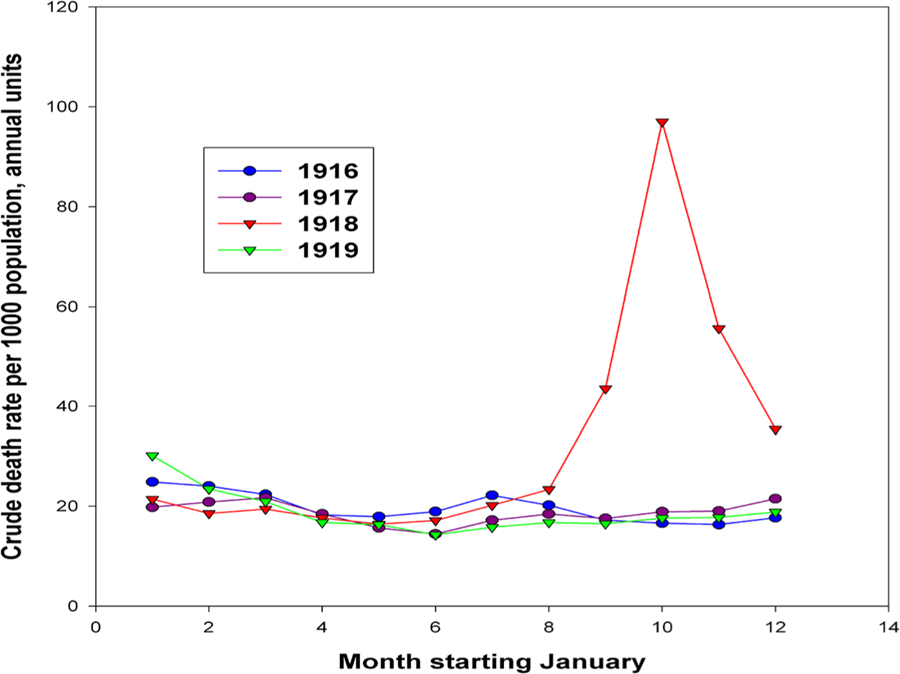
Crude death rates by month (per 1000 population) in Italy in 1916–1919. Rates computed on an annual basis. Source: authors’ estimations based on (MAIC 1924, 1925a, 1925b)